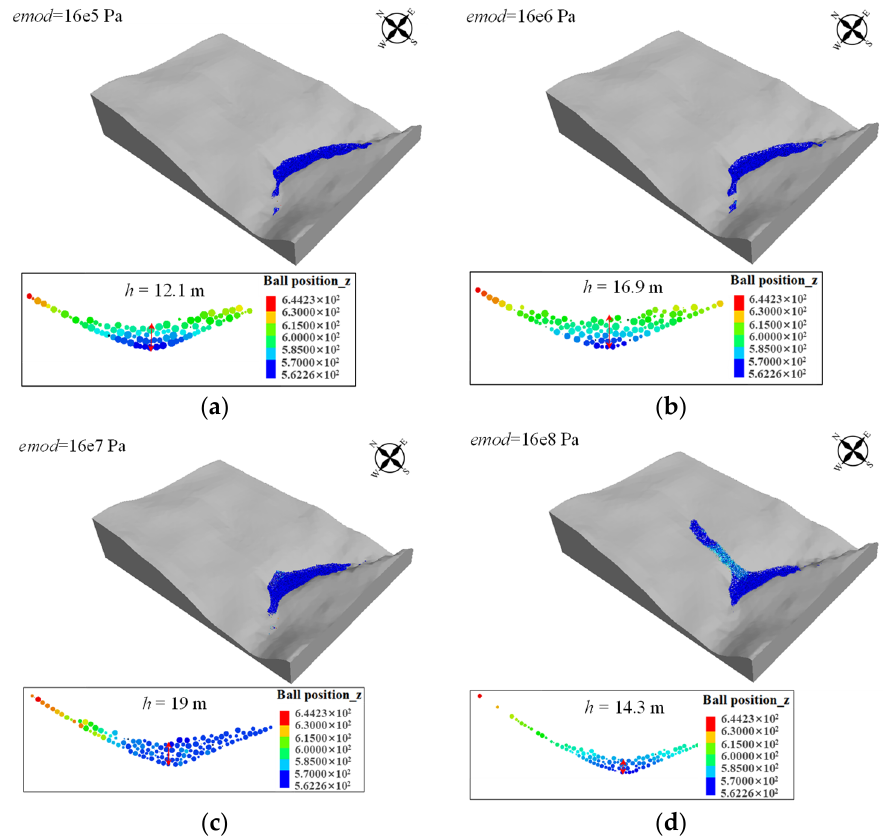
Figure 18. Simulation results with different effective modulus of the particles: ( a ) emod = 16 × 10 5 Pa; ( b ) emod = 16 × 10 6 Pa; ( c ) emod = 16 × 10 7 Pa; ( d ) emod = 16 × 10 8 Pa.